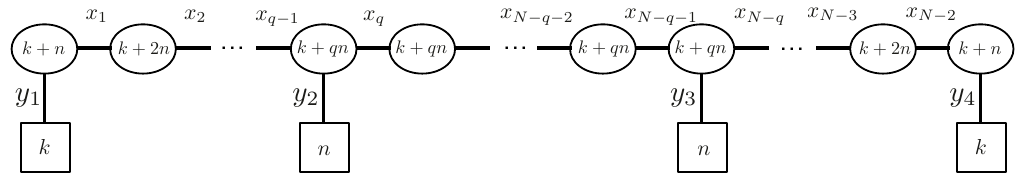
Figure 11 . The symmetric